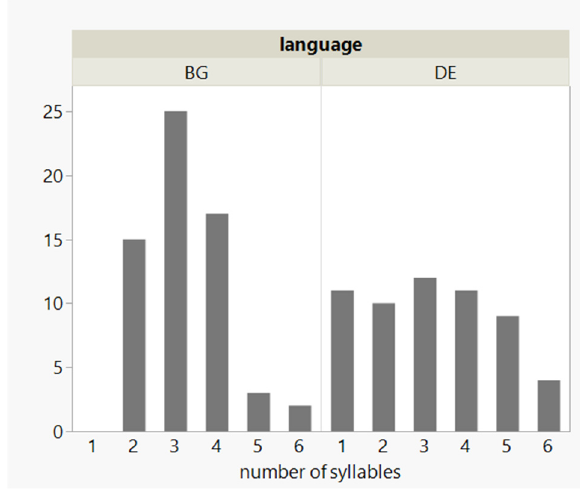
Figure 5. Number of syllables in the prosodic word in Bulgarian (left) and German (right).